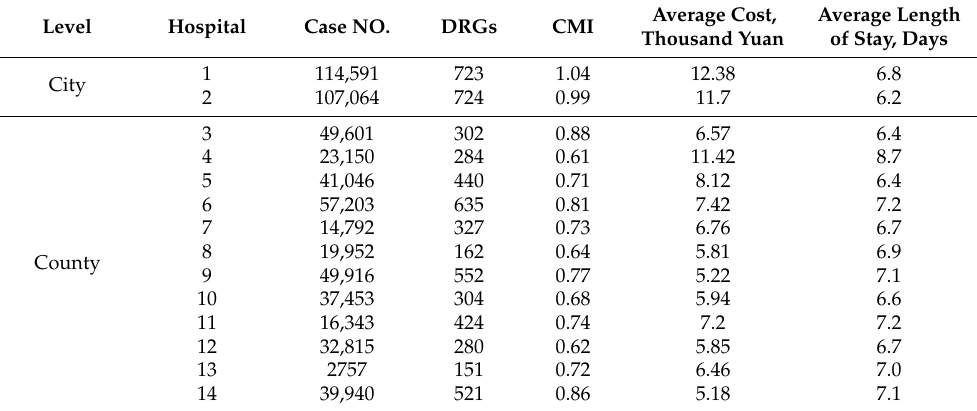
Table 1. Baseline characteristics of sample hospitals.